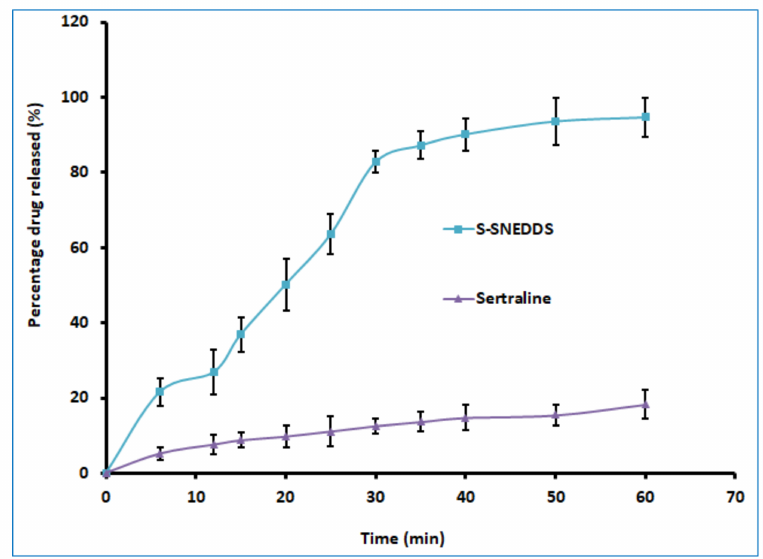
Figure 9. Comparison of release profile of prepared solid self-nanoemulsifying drug delivery system (S-SNEDDS) and sertraline (control). Data represented are mean ± SD ( n = 6).